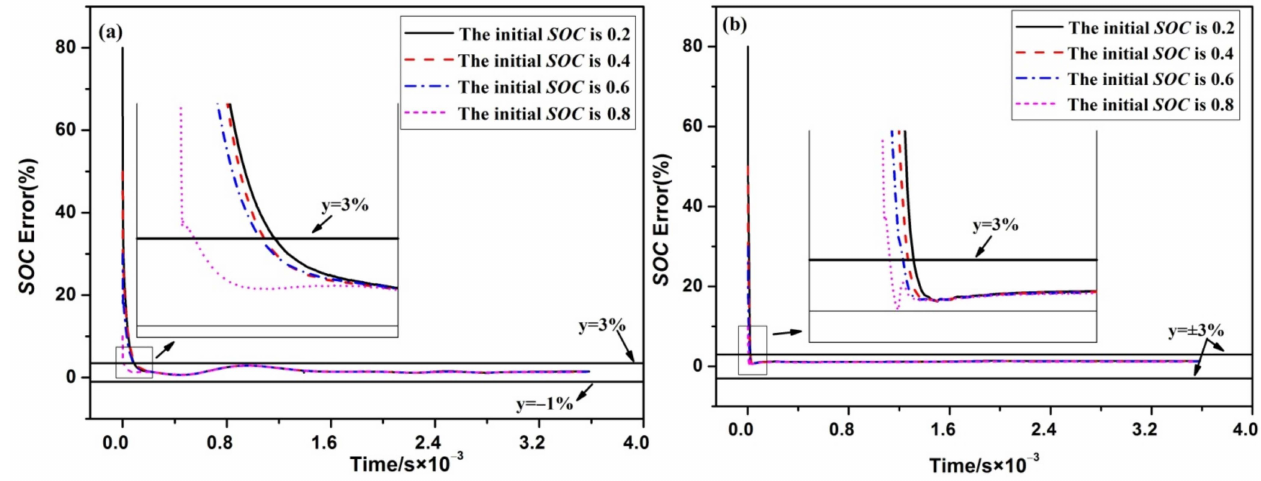
Figure 7. The comparison of SOC estimation error at different initial SOC values: ( a ) under the ISH I algorithm, ( b ) under the IIAE